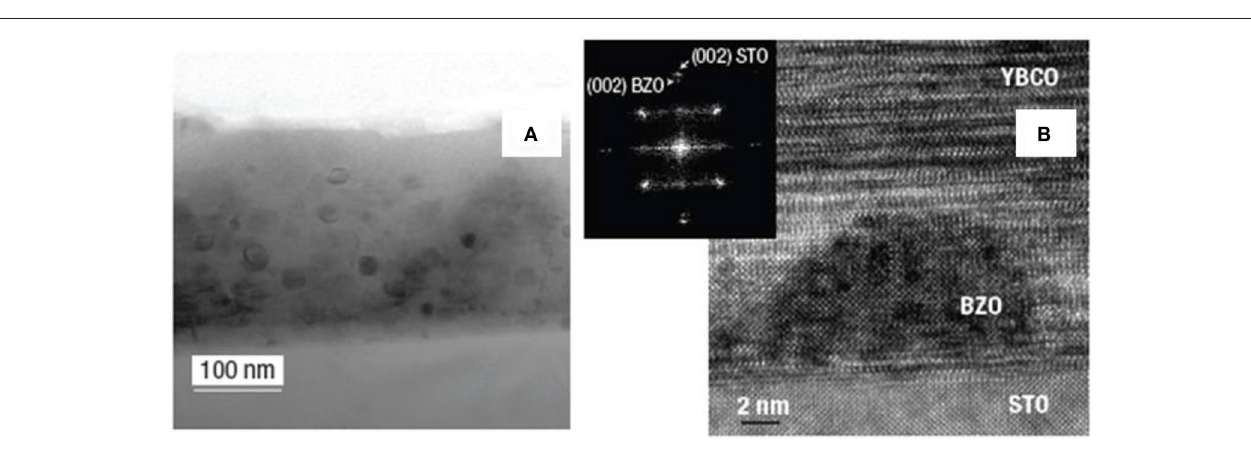
of RE BCO thin films [99, 100]. It has been suggested that the lattice mismatch is appropriate for superior vortex pining if it is in the range of 5–12%